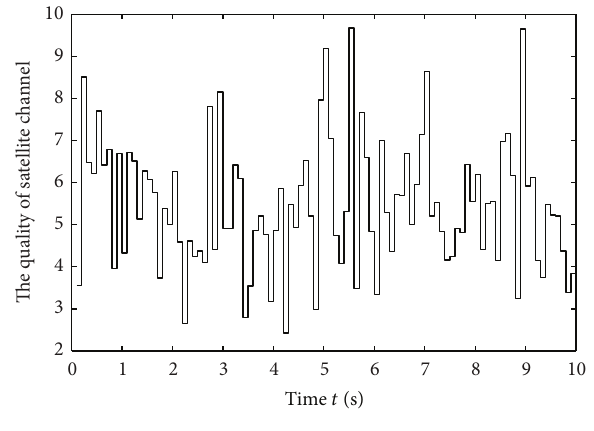
Figure 6: The state of channel quality.